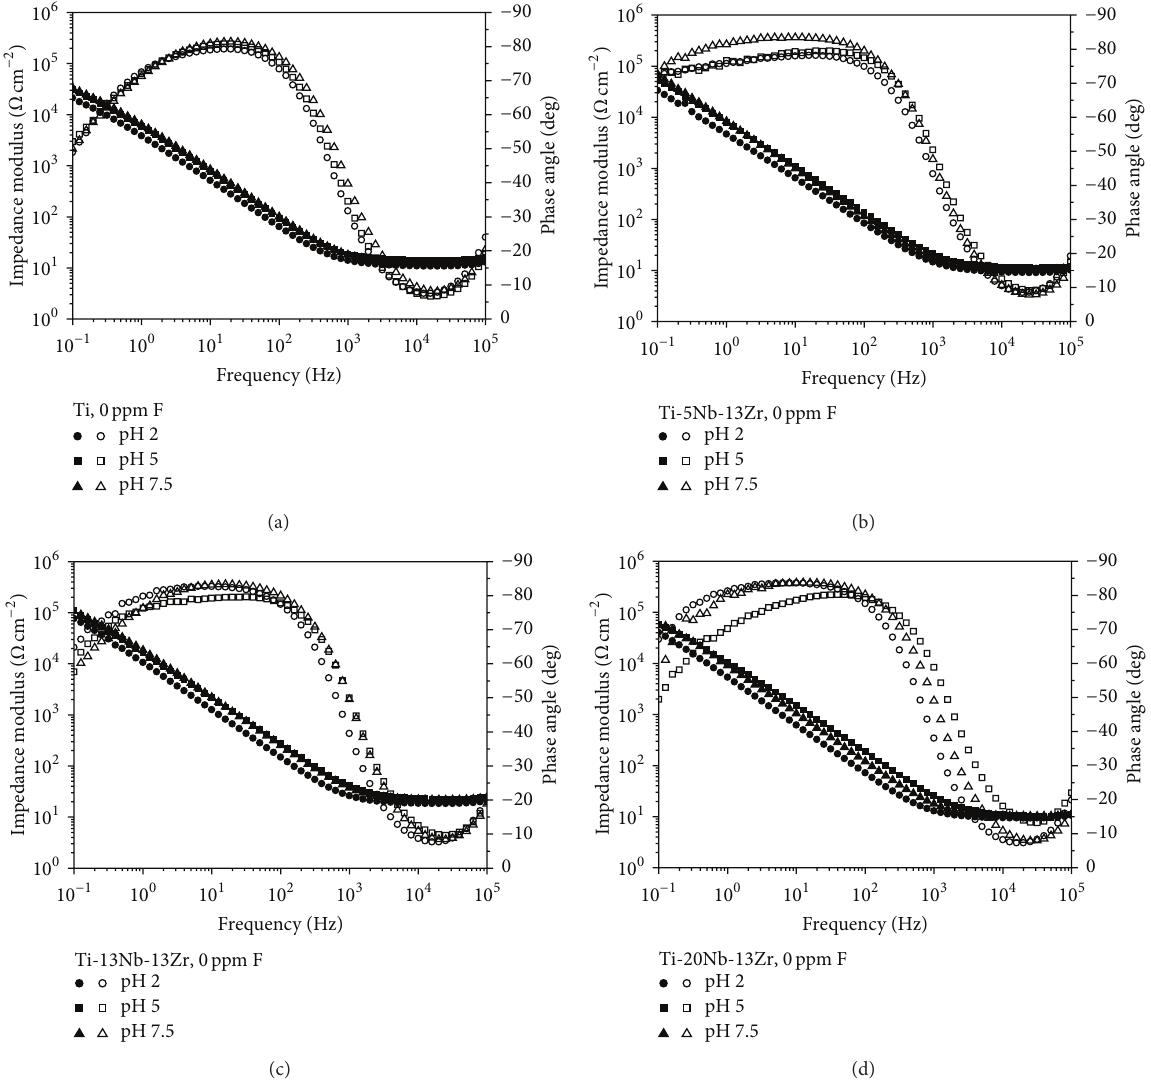
Figure 7: Bode diagrams of (a) CP-Ti, (b) Ti-5Nb-13Zr, (c) Ti-13Nb-13Zr, and (d) Ti-20Nb-13Zr obtained at OCP in Ringer’s solution of pH 2, 5, and 7.5 at 37 ∘